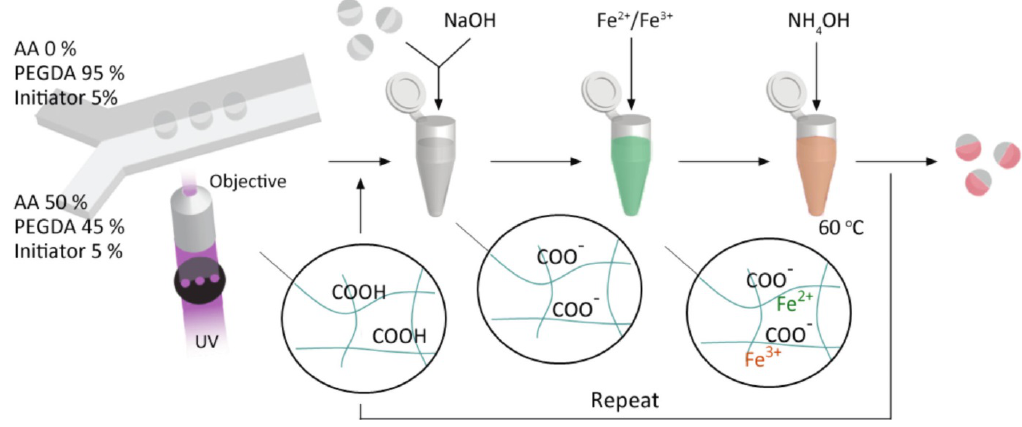
Figure 36. Schematic representation of the coprecipitation process in photo-polymerized microgels with ~20 µm diameter prepared in a microfluidic channel. After deprotonation in 0.5 M NaOH and rinsing with 0.5% Tween 20 to reach pH 7, 0.2 M FeCl solutions were mixed with microgels at a Fe 3+ :Fe 2+ ratio of 1:75. After diffusion of the iron ions in the polymer particles, excess salts were removed. After the addition of NH 60 °C, MNPs were nucleated and grown in situ before a final rinse with Tween 20. All these steps were repeated several times for successive growth cycles. Reprinted with permission from [63]. Copyright 2012 American Chemical